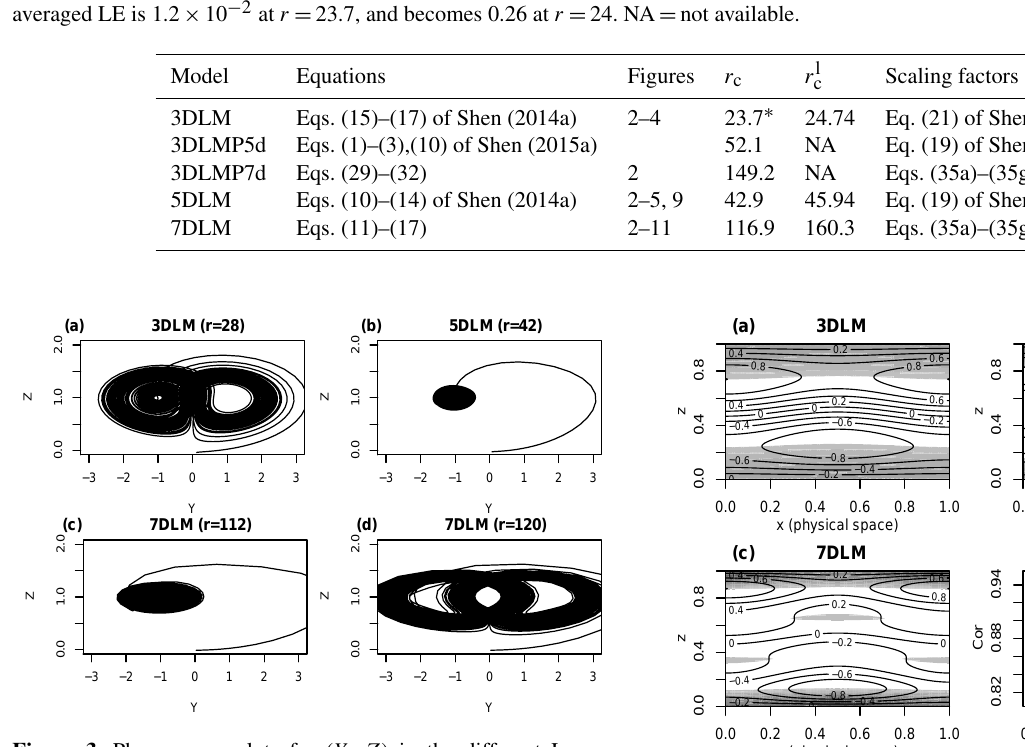
Figure 3. Phase space plots for ( Y , Z ) in the different Lorenz models. (a) Lorenz strange attractors with r = 28 in the 3DLM. (b) A stable solution with r = 42 in the 5DLM. (c, d) Stable and chaotic solutions with r = 112 and r = 120 in the 7DLM, respec- tively. All of the solutions are normalized by the corresponding critical points, namely, Eq. (21) of Shen (2014a) for the 3DLM, Eq. (19) of Shen (2014a) for the 5DLM, and Eq. (35) for the 7DLM.